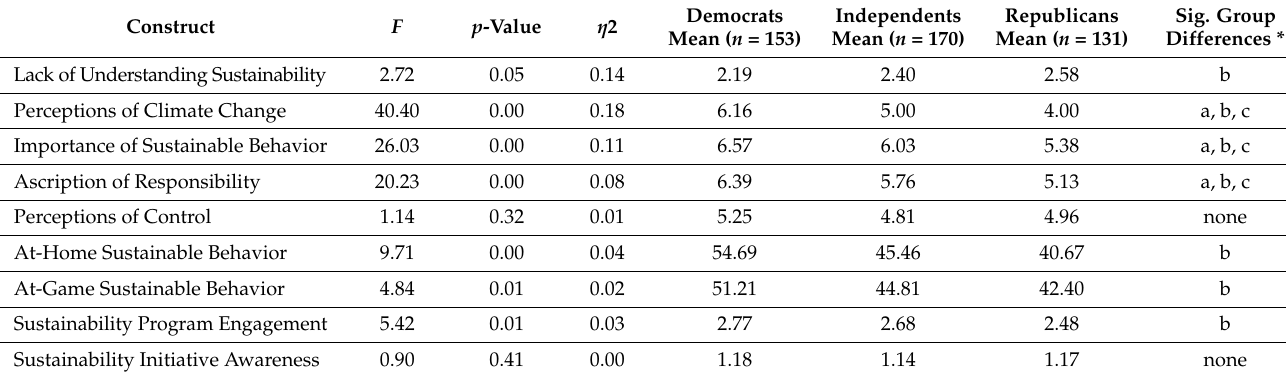
Table 2. MANOVA—Differences in Constructs Based on Political Party